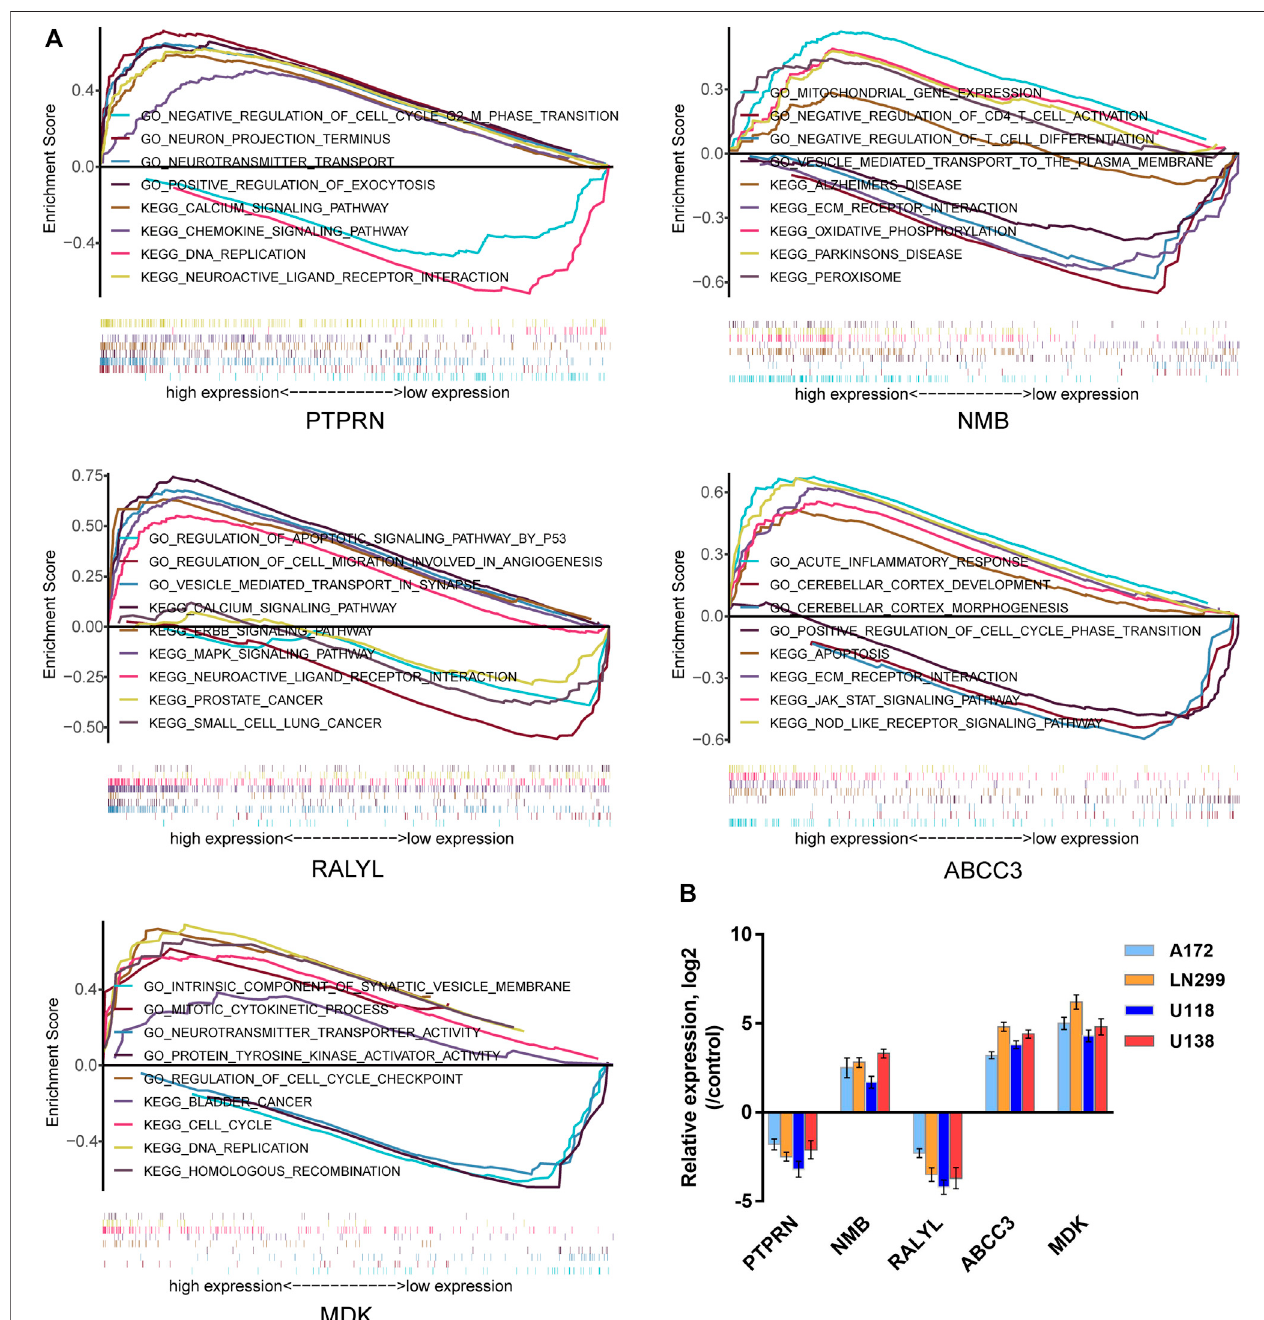
FIGURE 11 | The potential biological function of the fi ve-mRNA signature in GBM. (A) Gene set enrichment analysis (GSEA) using strati fi ed fi ve-mRNA signature expression levels for genes downregulated or upregulated in GBM. The GSEA results showed the correlation between the fi ve-mRNA levels and potential biological functions in the Gene Ontology (GO) and Kyoto Encyclopedia of Genes and Genomes (KEGG) databases. (B) The relative expression levels of the fi ve-mRNA signature were determined by qRT-PCR in four human GBM cell lines.